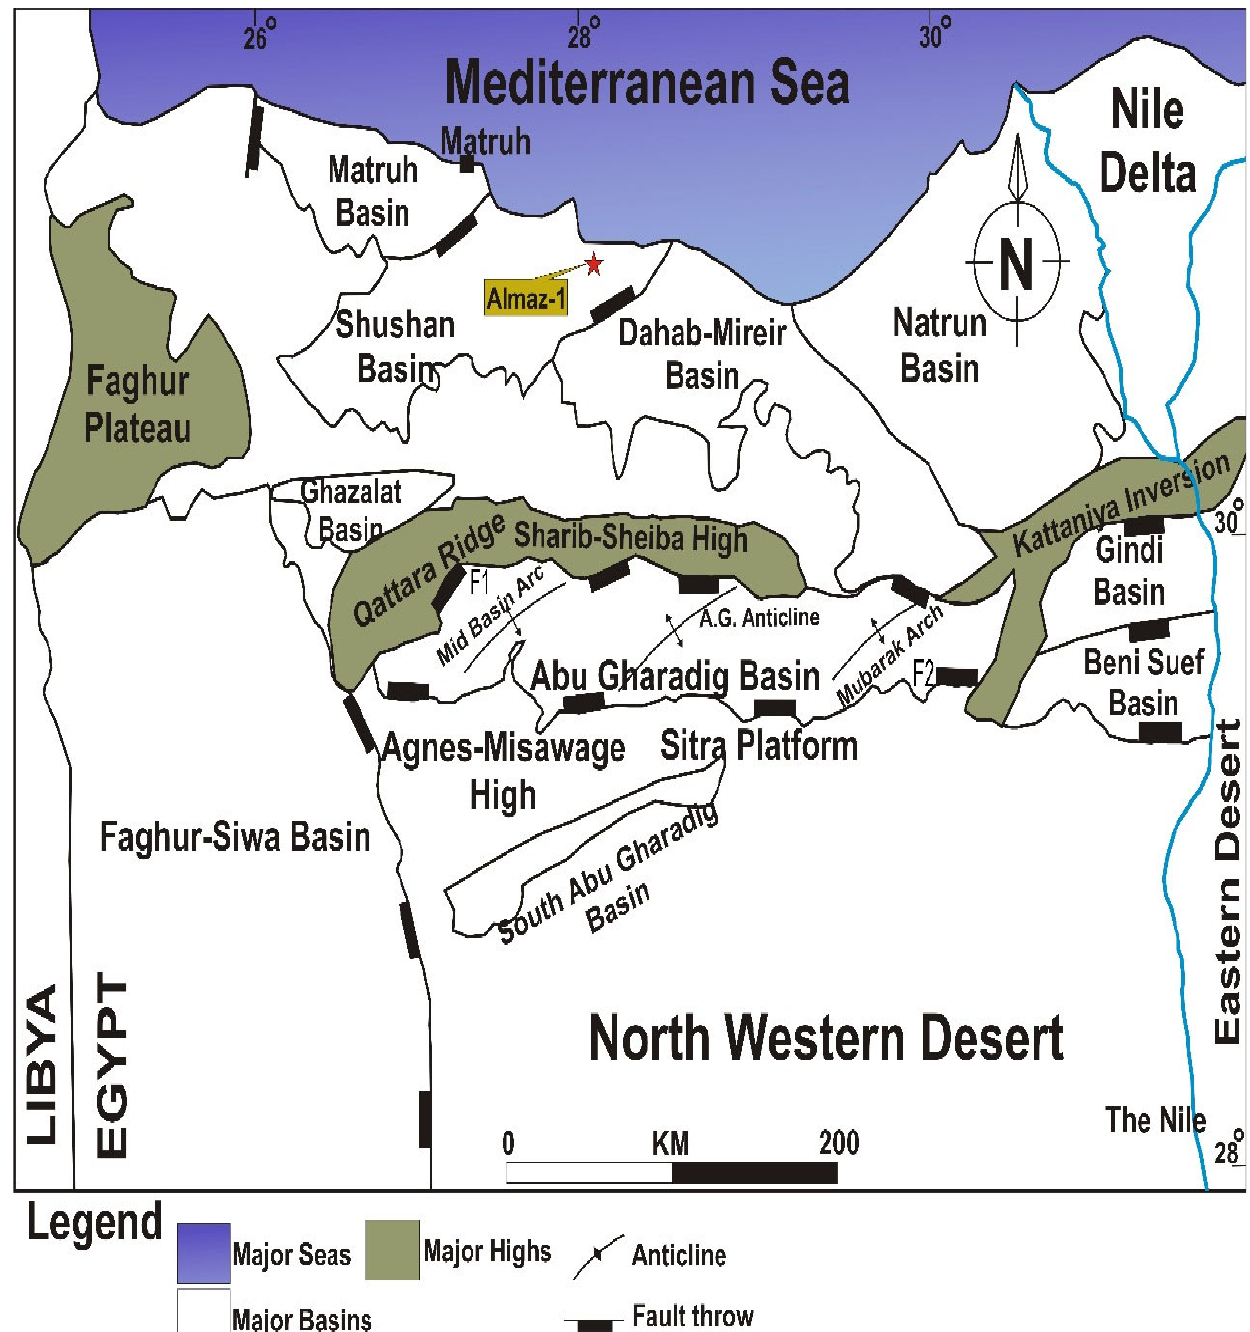
Figure 1. Location map of the Almaz-1 well (red star) along with major structural features in the north Western Desert, Egypt (modified after [4]).